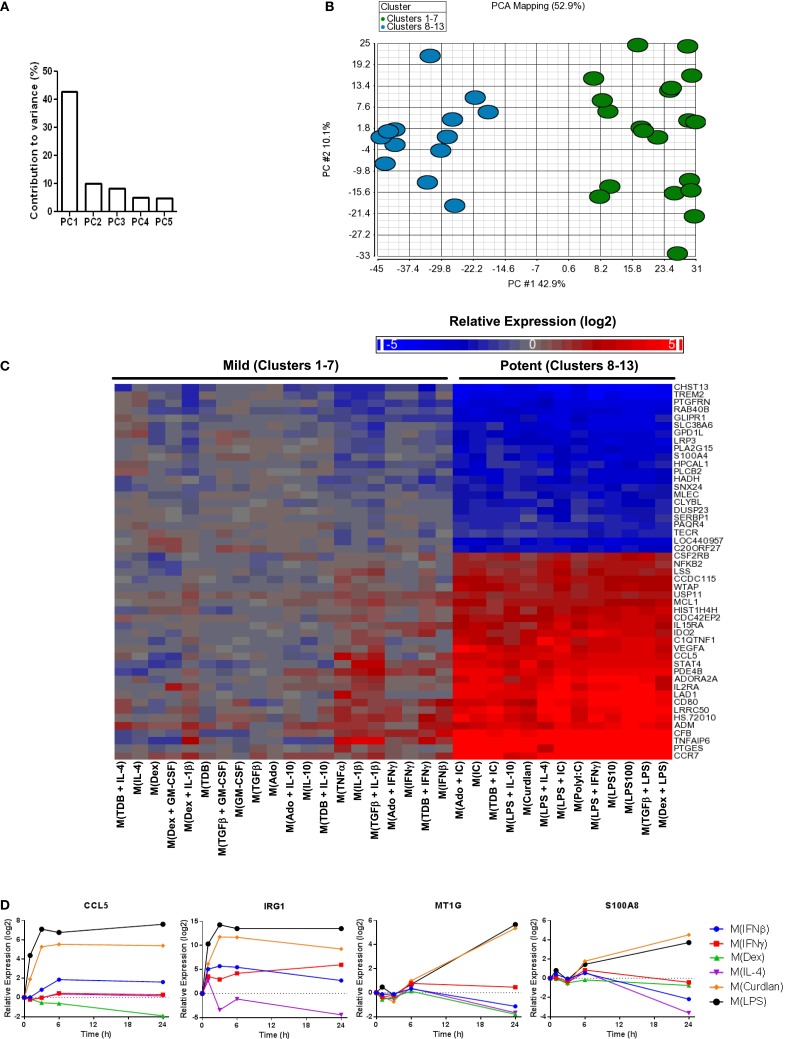
Transcripts universally regulated by “potent” macrophage-activating conditions in clusters 8–13 were the largest source of variance in the polarized MDM gene expression profiles. Principal components analysis was performed using the data set of 1874 regulated transcripts from the 33 gene expression profiles. (A) The contribution of PC1–PC5 to the variance is shown. (B) Scatterplot displays gene expression profiles according to PC1 and PC2 scores with color coding based on “mild” (clusters 1–7) and “potent” (clusters 8–13) categorization. (C) The 50 transcripts that contributed the most to PC1 were sorted according to unsupervised hierarchical clustering results. Changes in transcript expression levels relative to untreated MDMs are depicted as a heat map (log2 scale). (D) Using IFC-based RT-PCR and samples from Figure 1, the changes in expression for each indicated transcript relative to the untreated MDM controls was determined at the 1, 3, 6, and 24 h time points for the six types of activated MDMs (N = 1).